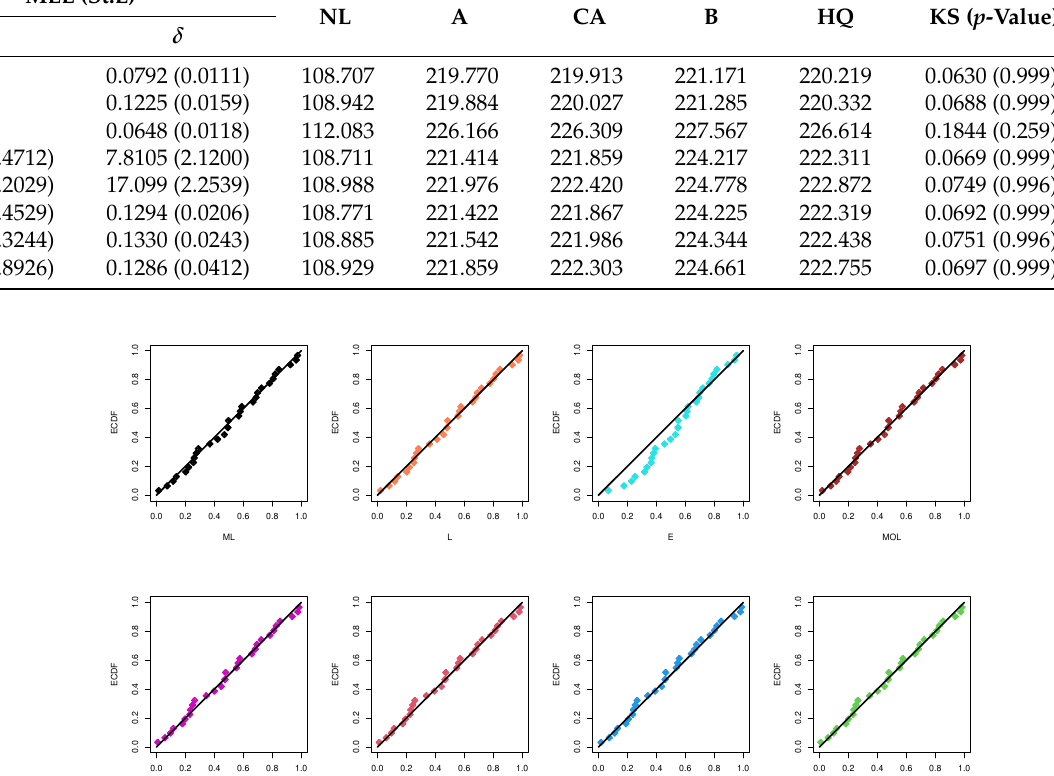
Figure 4. The QQ plots of ML and its competitive models from mechanical equipment